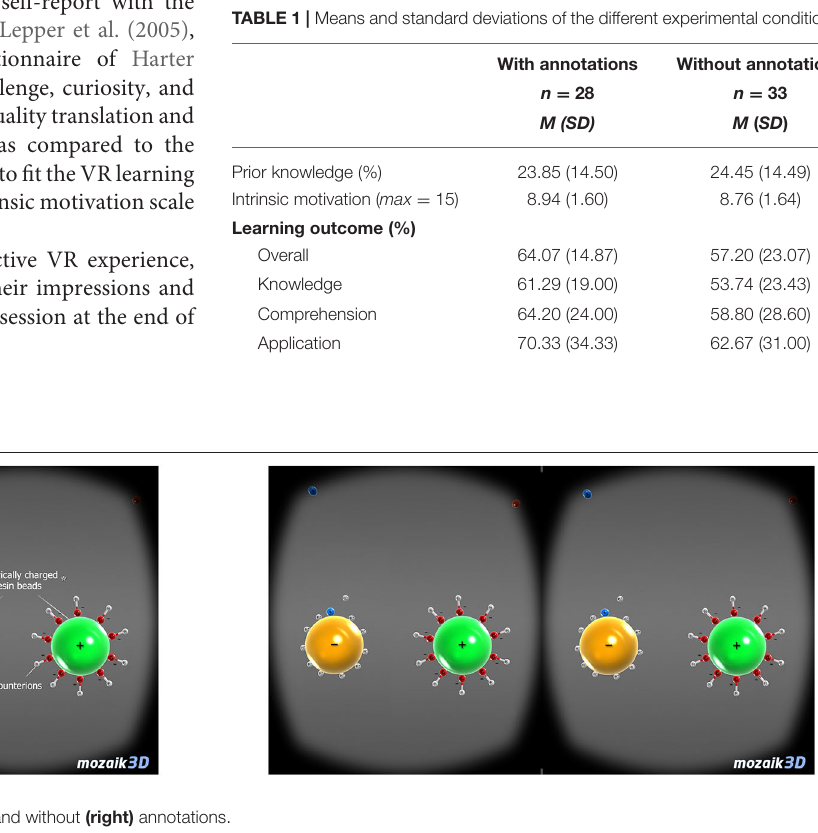
Frontiers in Psychology |